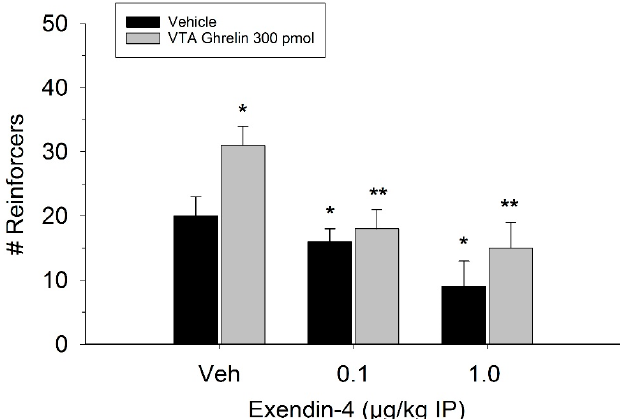
Figure 2. Peripheral injection of Ex-4 attenuated the effect of VTA ghrelin on operant responding. Values represent mean number of reinforcers ± SEM; n = 8. * p < 0.05 compared to vehicle (Veh). ** p < 0.05 compared to ghrelin paired with saline Veh pretreatment. Int. J. Mol. Sci. 2018 , 19 , x FOR PEER REVIEW